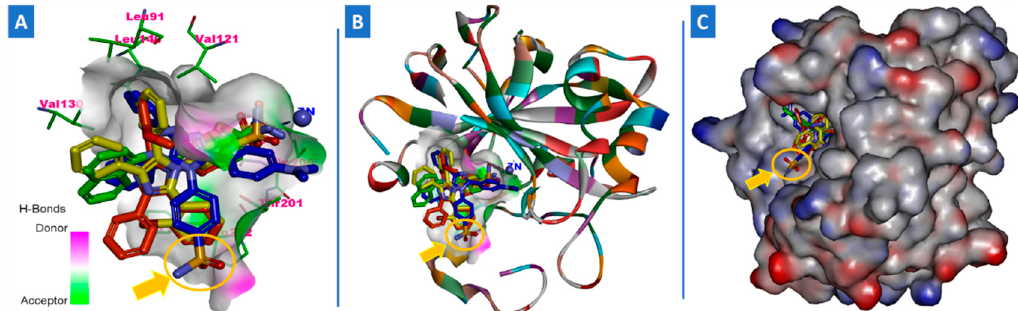
Figure 6. Overlay of the docked poses 5d , 5k , 5i and the co-crystallized ligand 9FK into the catalytic active site of CA-IX isoenzyme (PDB code: 5FL4). The protein is represented as: ( A ) solid surface colored according to atom charges; ( B ) secondary structure displayed in a solid ribbon (cartoon) style; ( C ) the window shows 3D magnification of superimposition of the four docked poses within the catalytic active site of CA-IX isoenzyme. The poses were rendered as stick model colored in green ( 9FK ), blue ( 5d ), orange ( 5k ) and yellow ( 5i ). Zn +2 cation is presented as a blue sphere. H-bonds are represented as dashed green lines. All hydrogens were removed for the purpose of clarity.